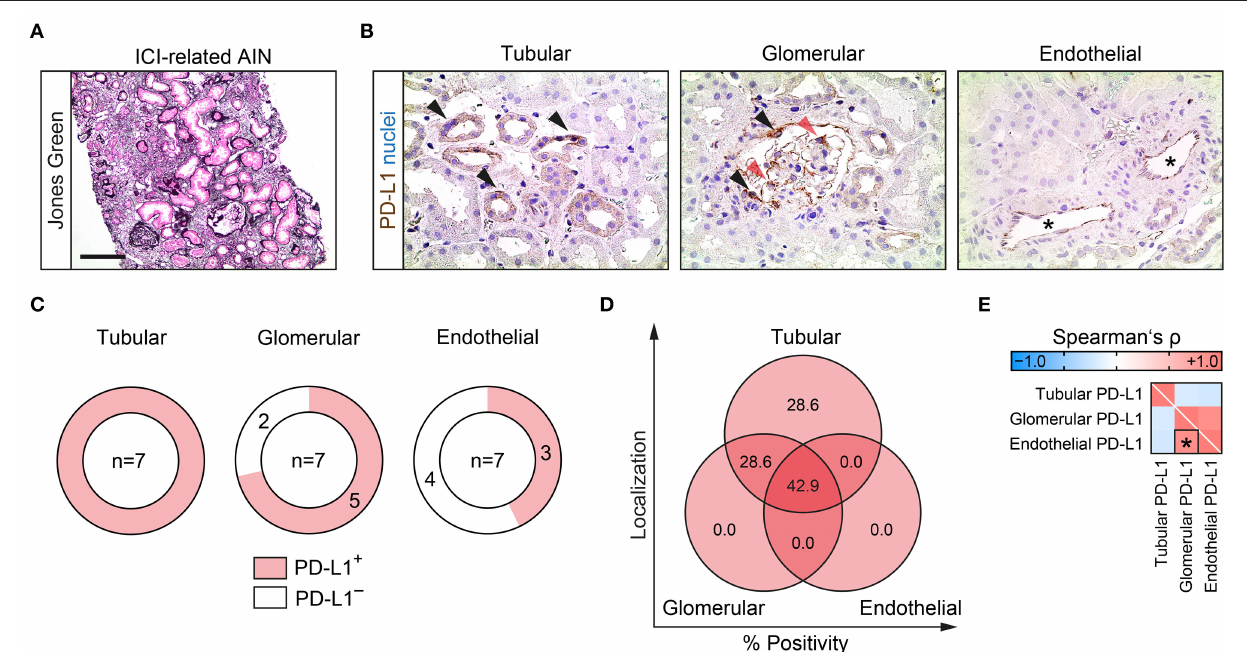
FIGURE 1 | PD-L1 localizes to different compartments in ICI-related nephrotoxicity. (A) Representative kidney biopsy with AIN related to ICI therapy stained for Jones Green (scale bar: 200 µ m). (B) PD-L1 positivity within tubular (proximal tubular epithelial cells depicted by black arrowheads), glomerular (parietal epithelial cells depicted by black arrowheads, and podocytes by red arrowheads) and endothelial compartments (asterisks). (C,D) Frequency of PD-L1 positivity among different renal compartments. (E) Correlative analysis of PD-L1 positivity within different renal compartments in ICI-related nephrotoxicity are shown by heatmap reflecting mean values of Spearman’s ρ . The rectangle box indicates a Spearman’s ρ more than ± 0.6, the asterisk a significant correlation in the linear regression analysis ( p < 0.05). AIN, acute interstitial nephritis; ICI, immune checkpoint inhibitor; PD-L1, programmed cell death protein 1-ligand